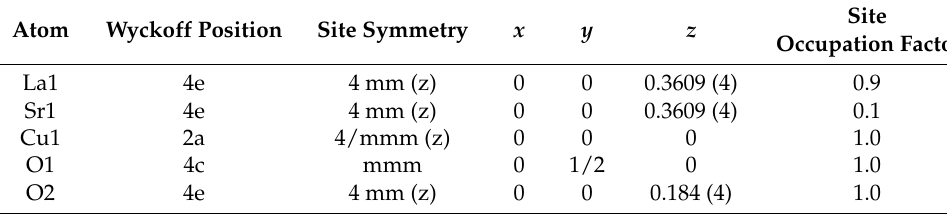
Table 2. Atomic coordinate of La 2 − x Sr x CuO 4 nanoparticles with x = 0.20.